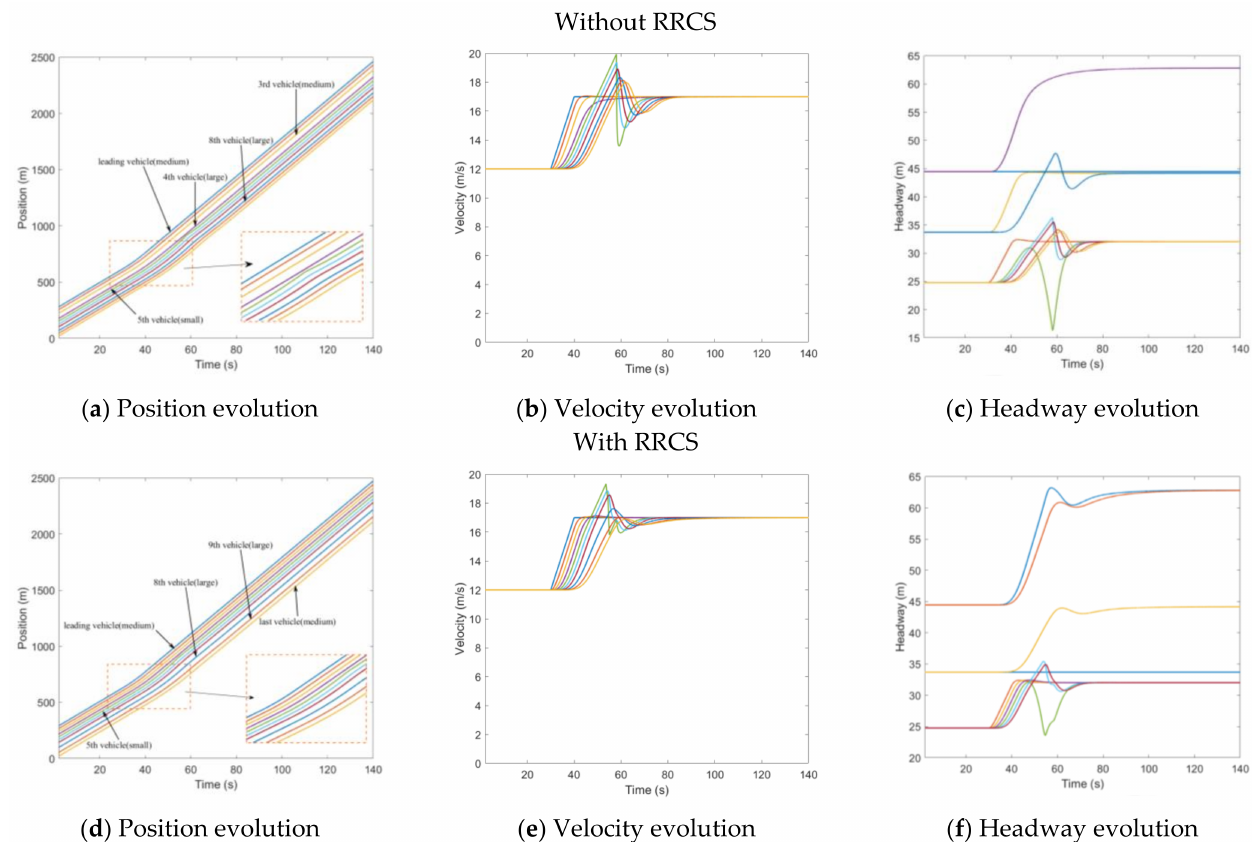
Figure 7. Mixed traffic flow evolution diagrams under replay acceleration attacks with/without